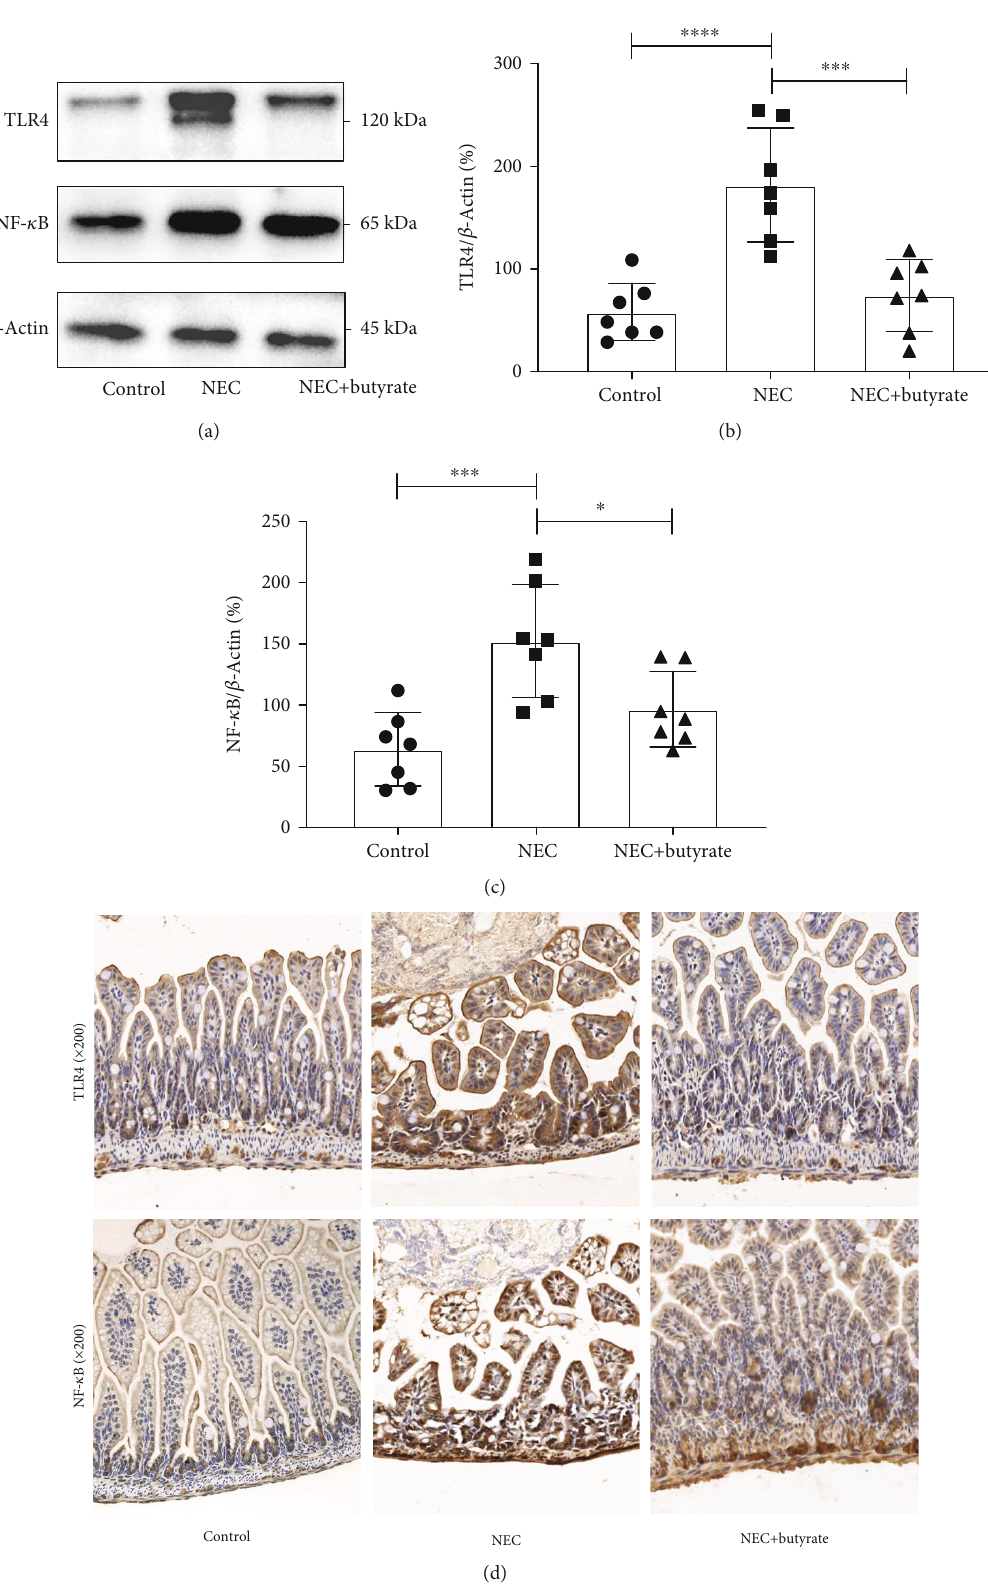
Figure 5: (a – c) TLR4 and NF- κ B protein expression levels in the three groups as determined by western blot analysis. (d) TLR4 and NF- κ B protein expression levels as determined by immunohistochemistry and observed under a microscope at 200x magni fi cation. Number of samples: control ( n = 7 ), NEC ( n = 7 ), and NEC+butyrate ( n = 7 ). Statistical analysis: one-way ANOVA. ∗ P < 0 : 05 ; ∗∗∗ P < 0 : 001 ; ∗∗∗∗ P < 0 : 0001